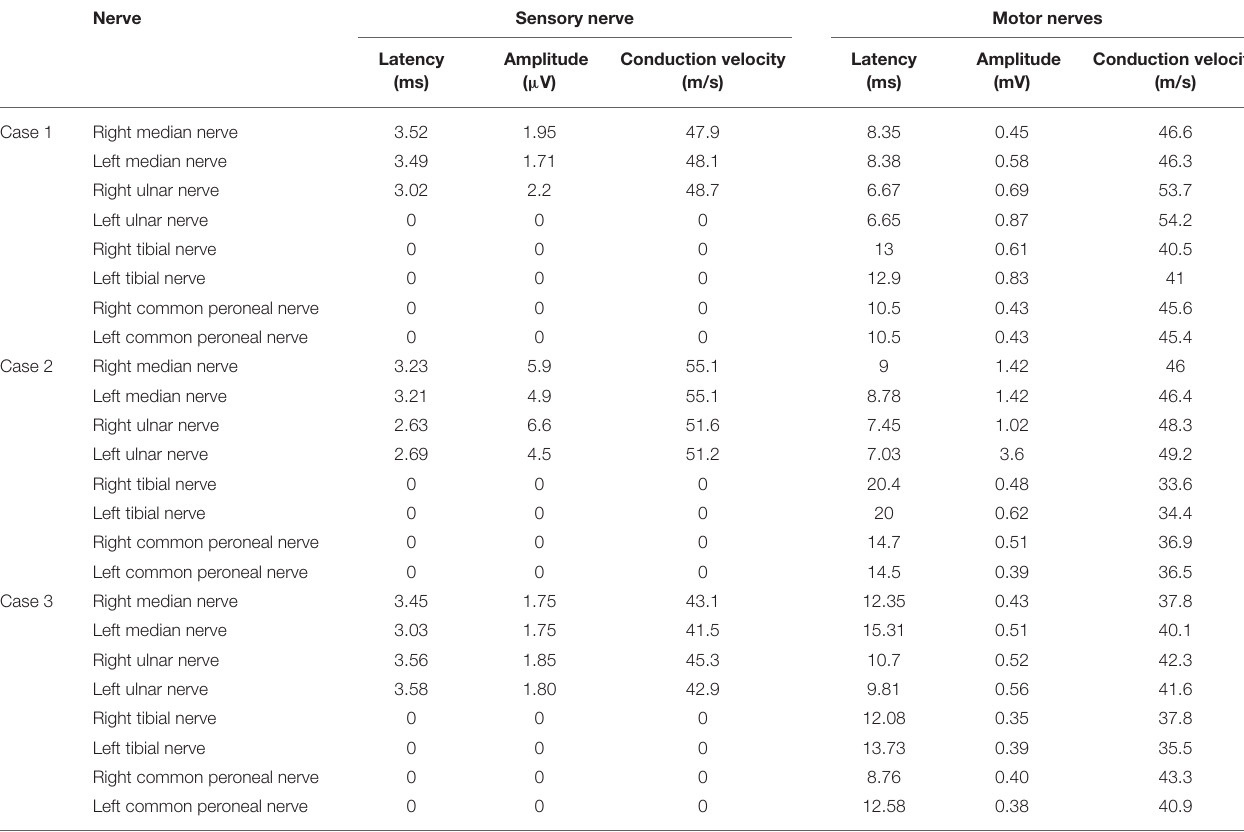
TABLE 2 | The conduction velocity of